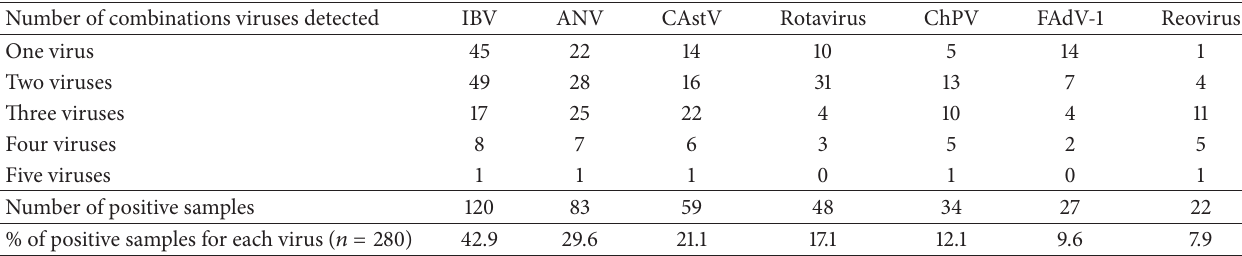
Table 3: Frequencies of individual and multiple enteric virus infections detected in intestinal samples.